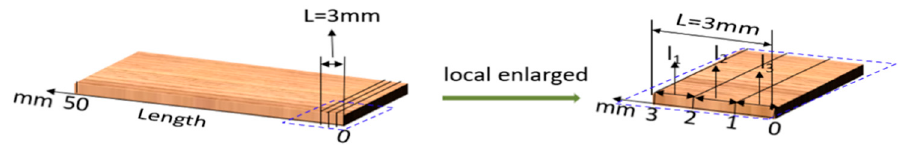
Figure 1. Screenshots of l 1 , l 2 , and l 3.